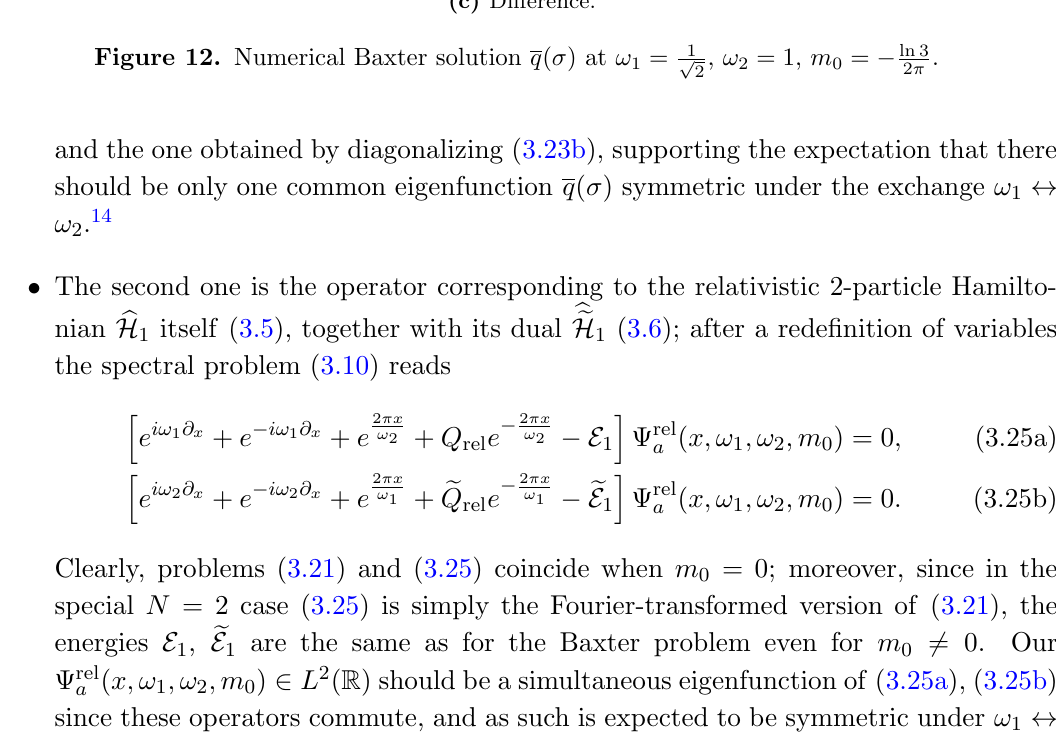
Figure 12. Numerical Baxter solution q ( (cid:27) ) at ! 1 = 1 p